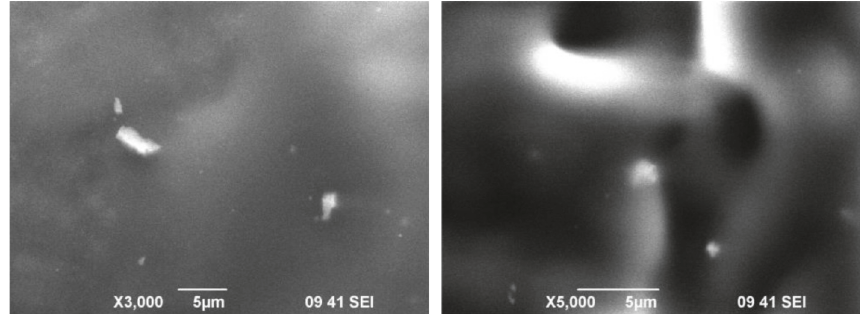
Figure 10: Asphalt without GO.